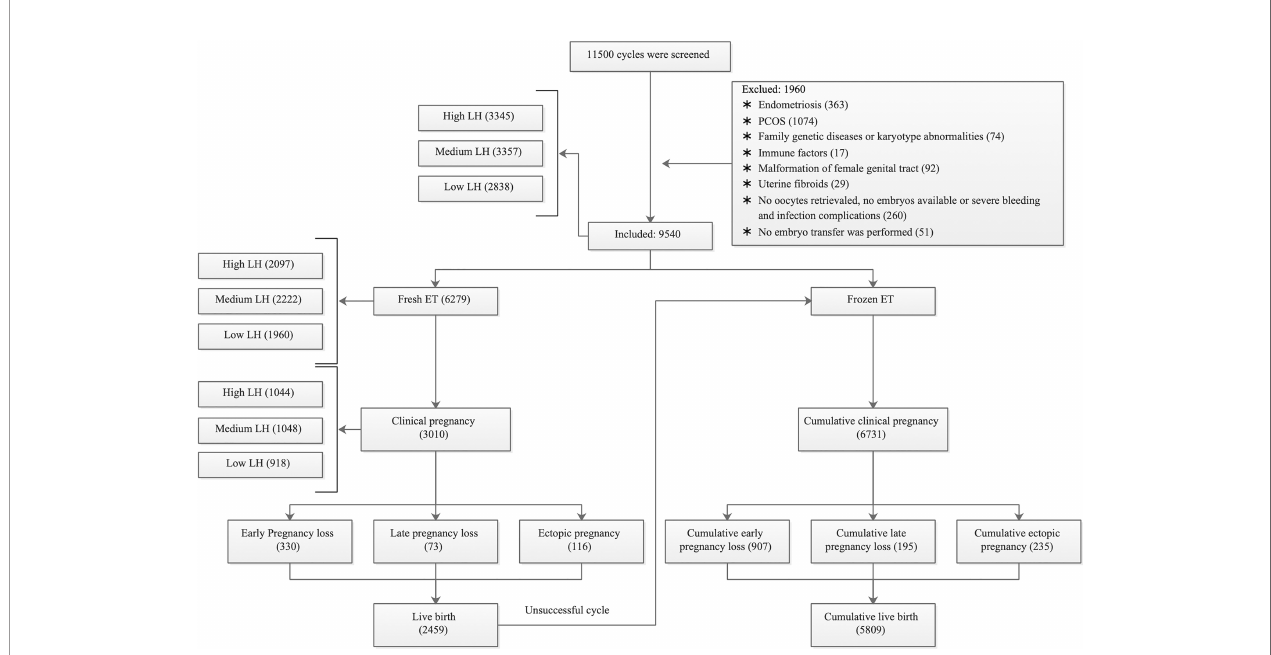
FIGURE 1 | Flow chart of patient and cycle selection. PCOS = polycystic ovary syndrome; ET = embryo transfer. According to the LH level on the COS initiation day, we grouped high LH as ≥ 1.50 mIU/ml, medium LH as ranging from 1.00 – 1.49 mIU/ml, and low LH as <1.00